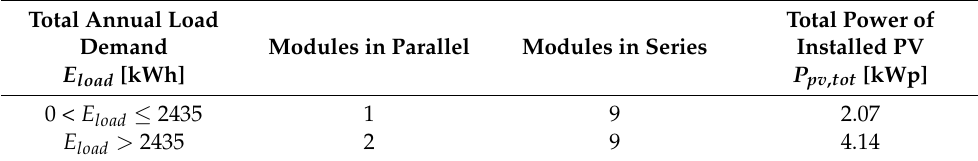
Table 2. PV sizing as a function of the total load